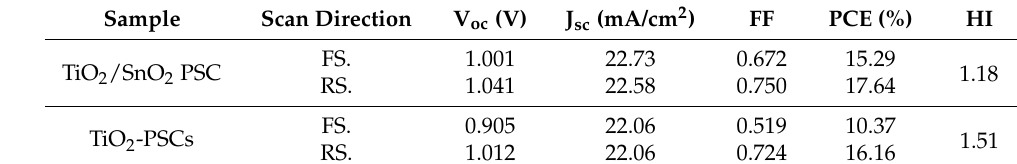
Table 1. Photovoltaics parameters of PSCs based on TiO 2 and TiO 2 /SnO 2 ETLs.